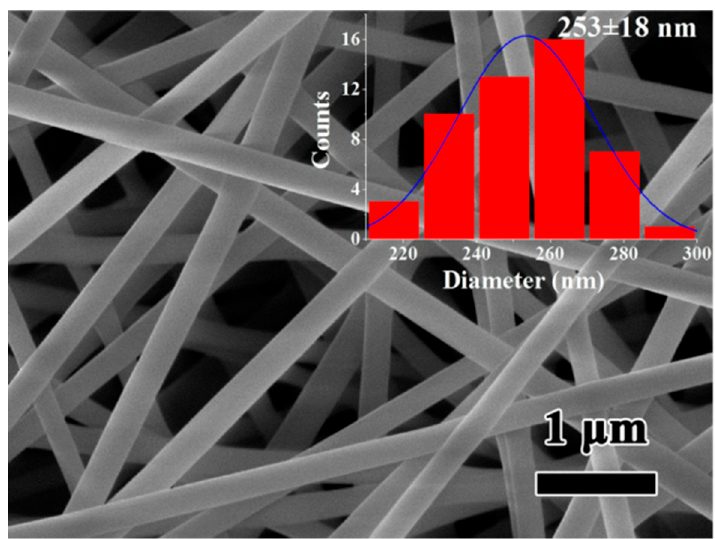
Figure 2. SEM image of polyvinyl alcohol (PVA) nanofibers (solution concentration 8%, applied electric field 17 kV, feed rate 0.010 mL/min, tip-to-collector distance 9 cm, needle type 20G), the inset is the histogram of diameter distribution.